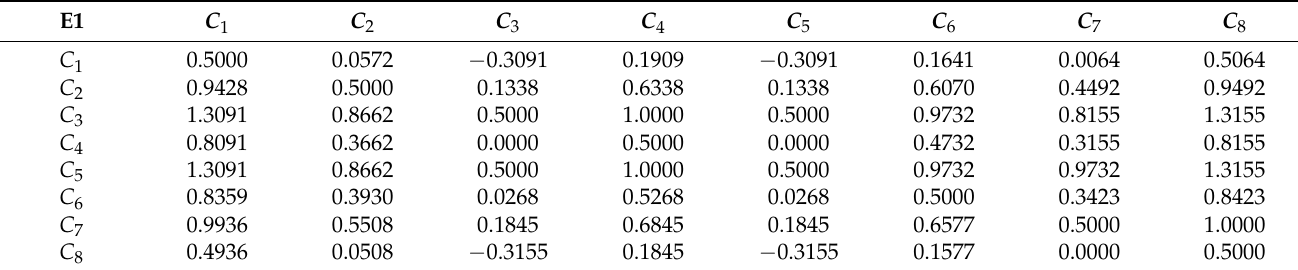
Table 4. CFPR matrix of criteria E1.